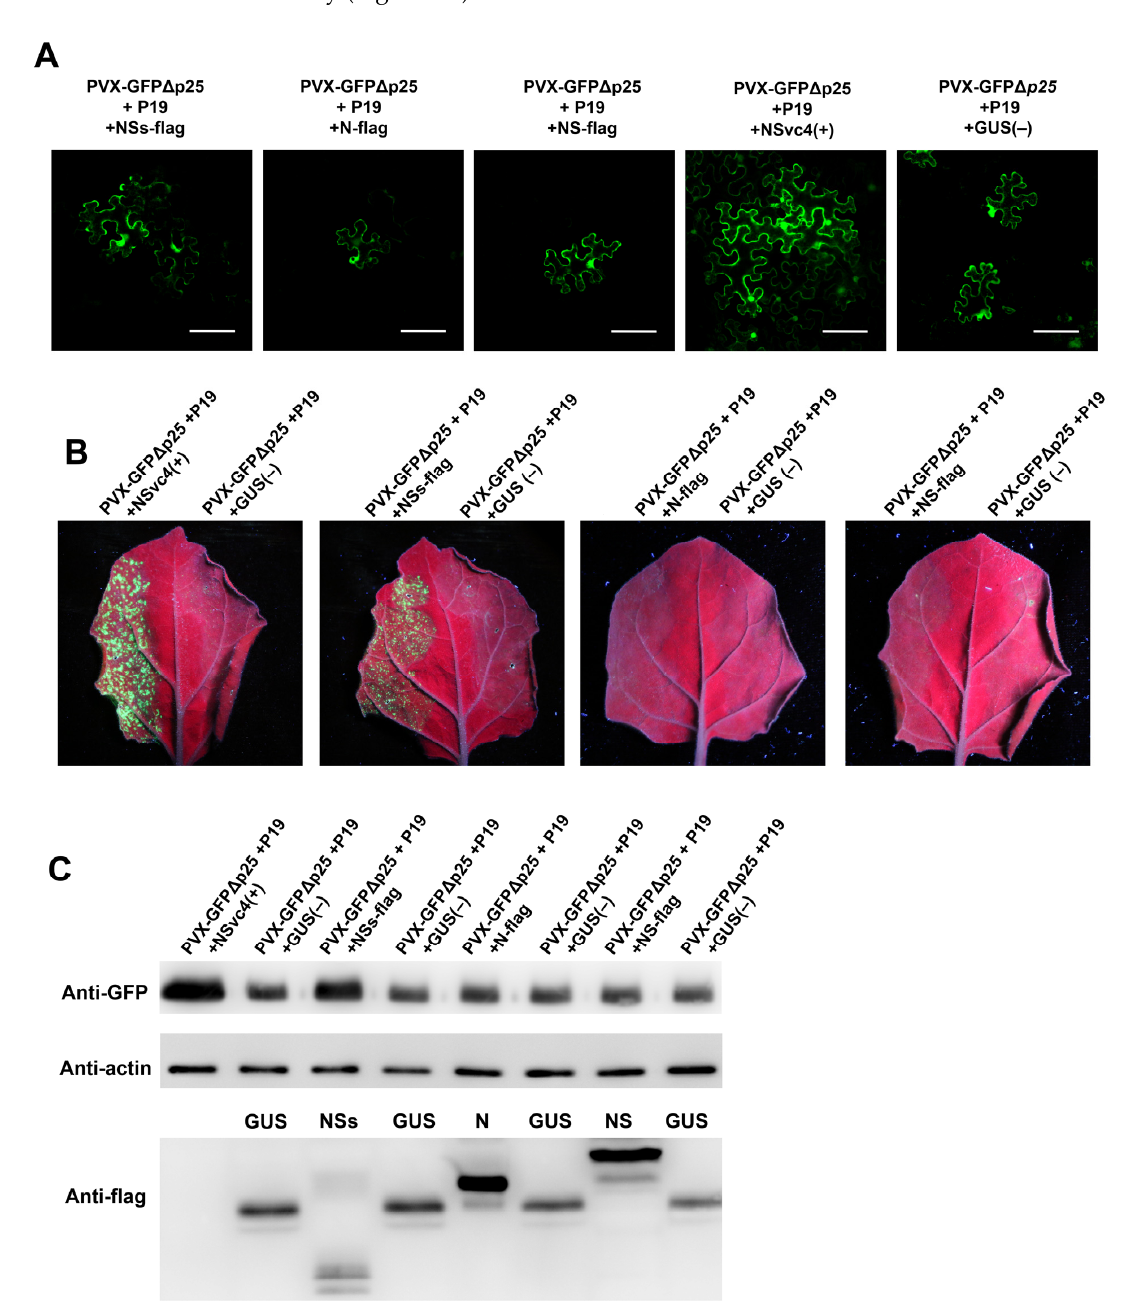
Figure 6. RDaBV NSs complement the intercellular movement of PVX- ∆ P25. ( A ) RDaBV NSs could complement the intercellular movement of PVX- ∆ P25. The co-infiltrated leaves were observed under a confocal microscope at 6 dpi. Bars, 100 µ m. ( B ) GFP fluorescence of co-infiltrated N. benthamiana leaves was observed by a UV lamp at 6 dpi. ( C ) Western blot analyzing GFP and viral protein expression levels in co-infiltrated N. benthamiana leaves. Actin was used as the internal reference.